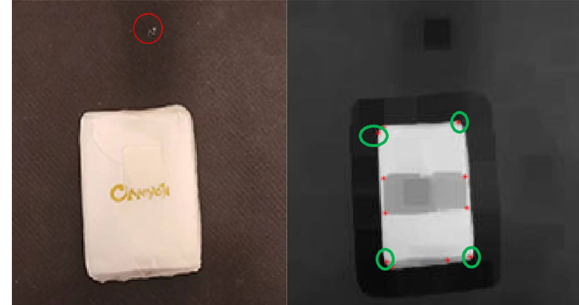
Figure 5. The corner